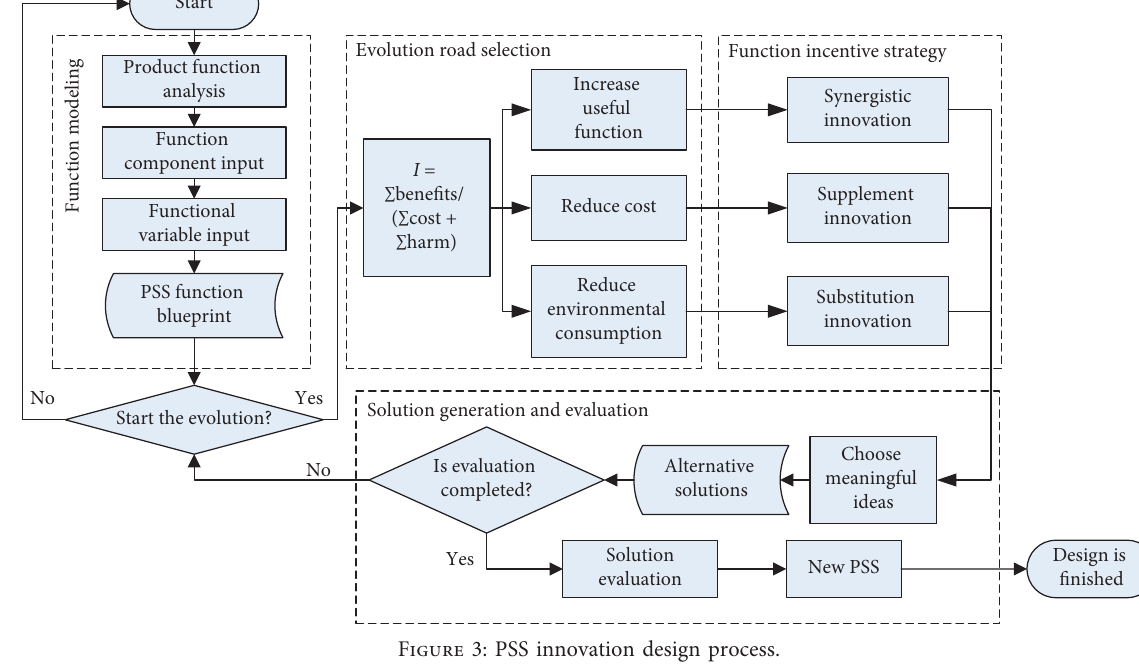
Figure 3: PSS innovation design